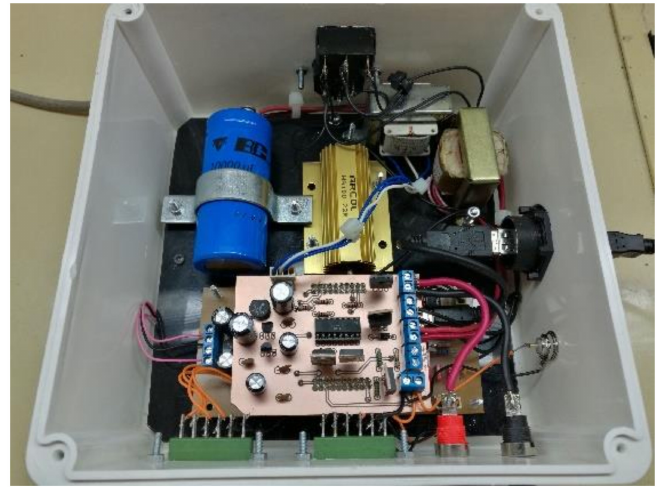
Figure 9. Prototype version used for the developed experimental